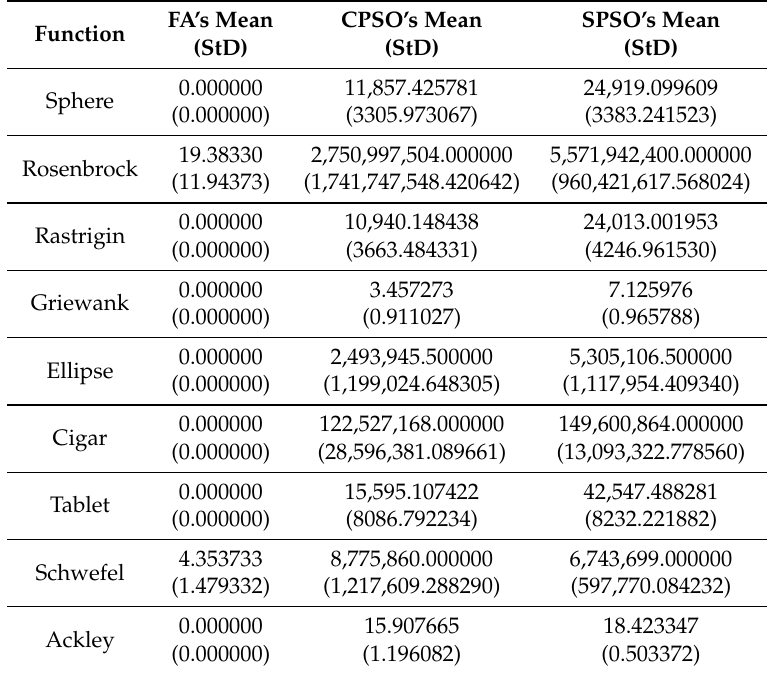
Table 1. Statistical mean and standard deviation of solutions found by the FA, the CPSO and the SPSO on nine benchmark functions over 20 independent runs of 10000 function evaluations [34].